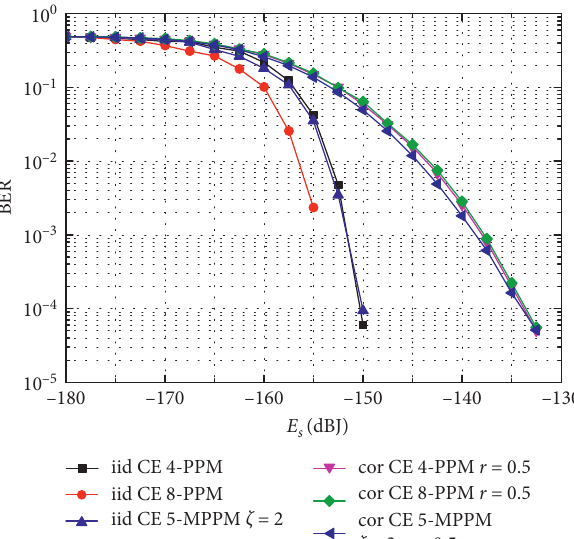
Figure 6: BER performance of different modulation methods in a2 × 2 MIMO system.